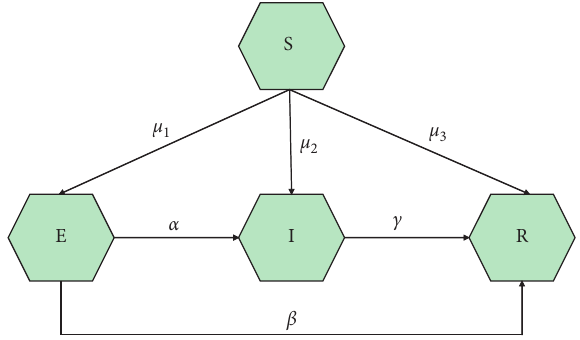
Figure 1: The contagion process of personal credit risk in SEIR model (the transformation direction and state of four credit subjects through different transformation coefficients in complex